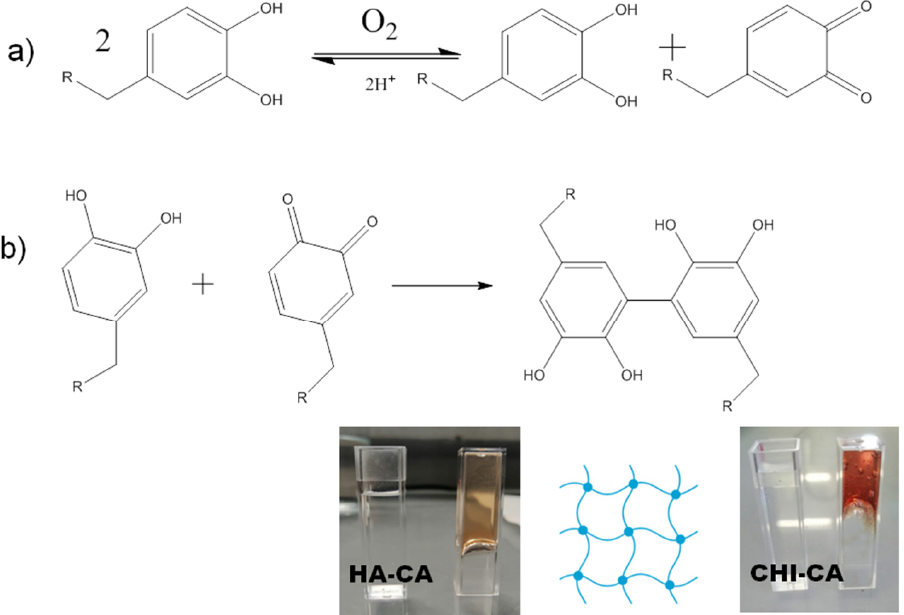
Figure 3. ( a ) Catechol group oxidation to quinone by atmospheric oxygen. ( b ) Crosslinking between catechol and quinone groups. R equals to CHI or HA.